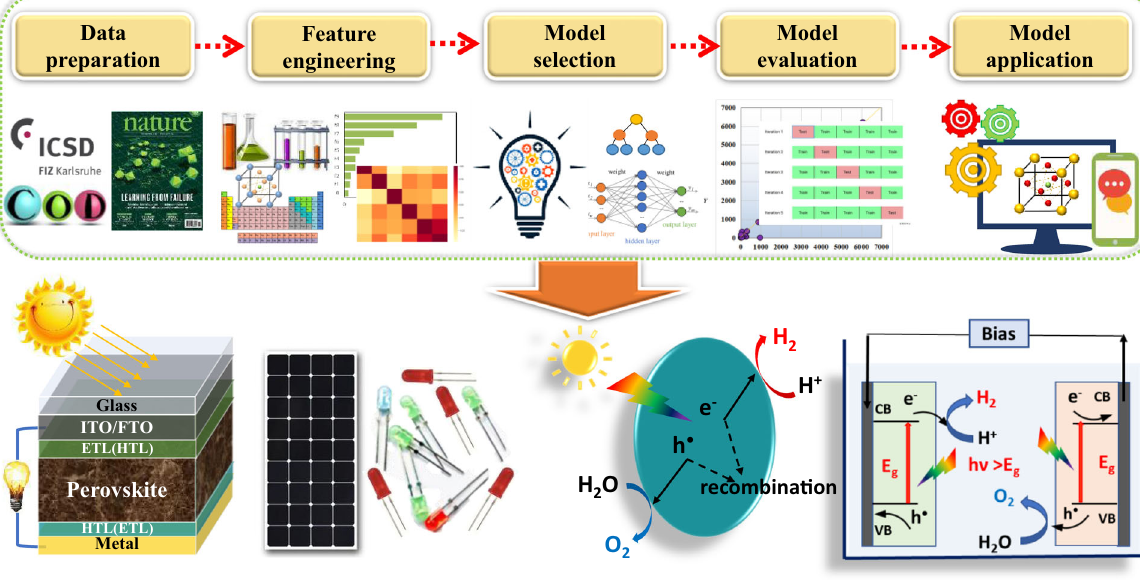
Fig. 2 The general work fl ow of ML in perovskite materials and related applications. Work fl ow of ML in perovskite materials includes data preparation, feature engineering, model selection, model evaluation and model